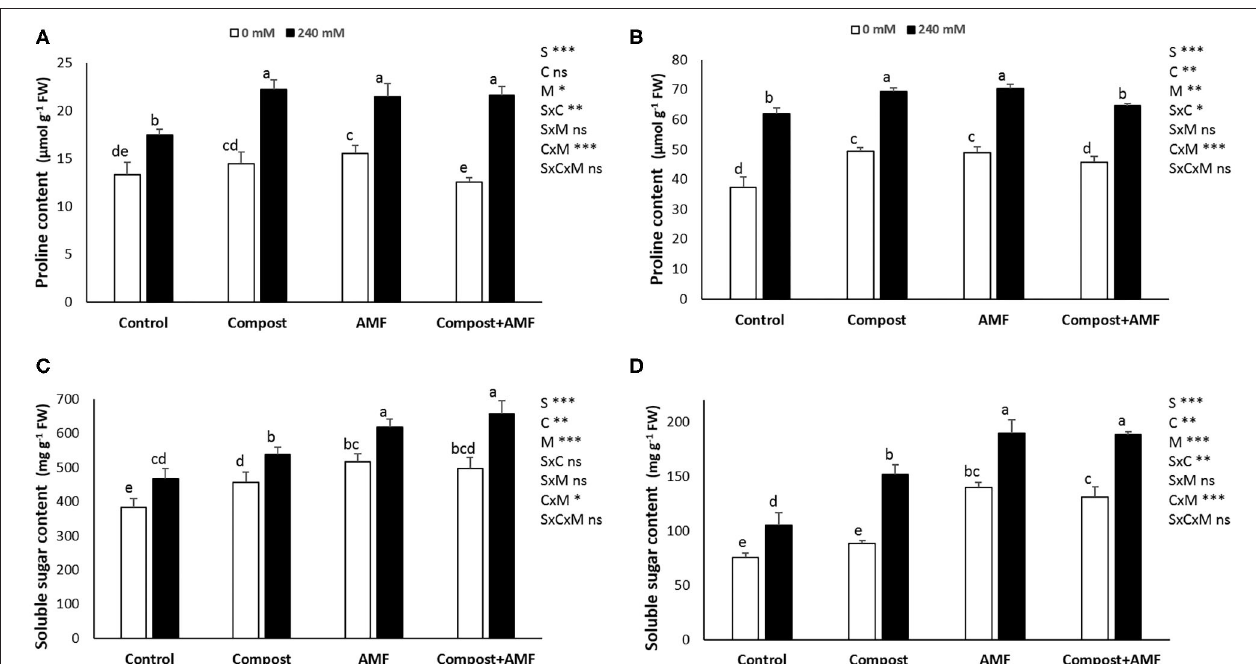
FIGURE 3 | Proline and soluble sugar content in the shoot (A,C) and the root (B,D) of date palm plants under saline and non-saline conditions after application of compost and AMF alone or in combination. The values of each parameter labeled by different letters indicate significant differences assessed by Duncan’s test after performing three-way ANOVA ( P < 0.05). ns non-significant; *significant at P < 0.05; **significant at P < 0.005; ***significant at P < 0.001.